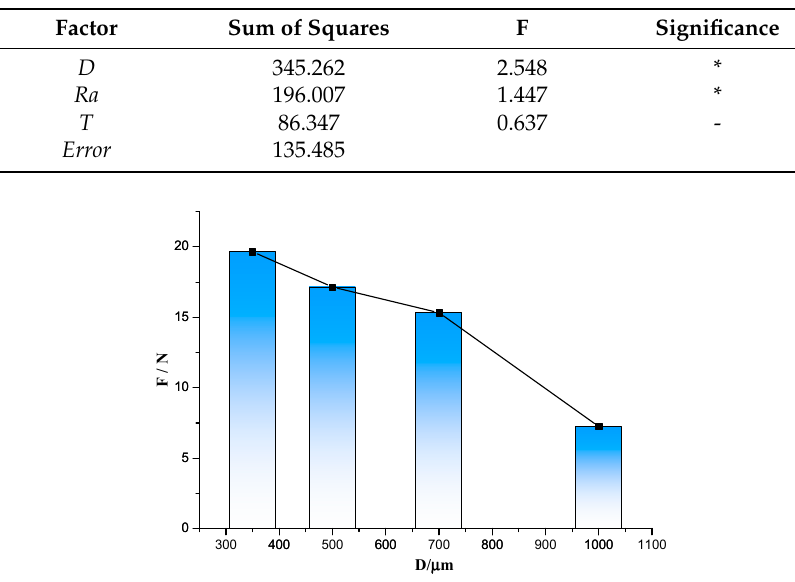
Figure 5. Relationship between the inner diameter and tensile force.